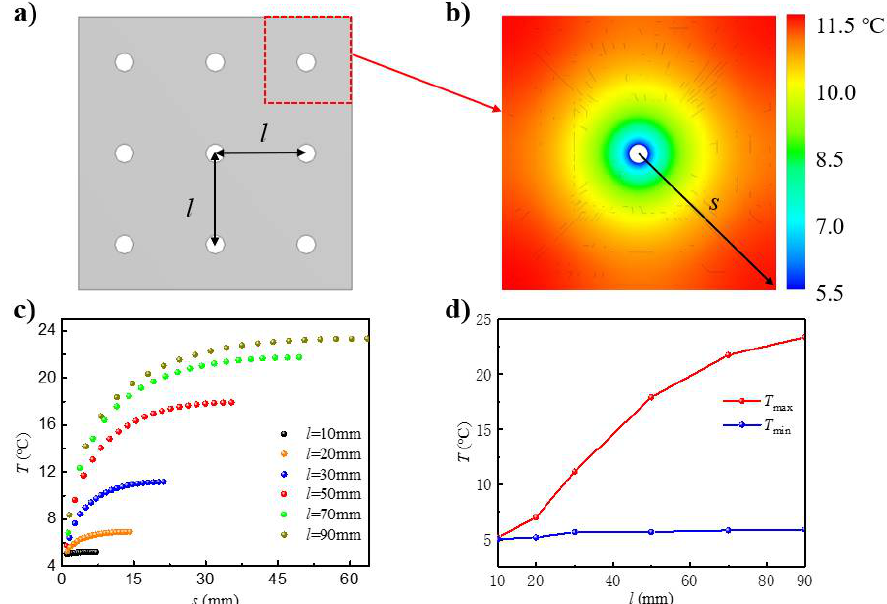
Figure 6. ( a ) Cross-sectional schematic of the active heat dissipation design with multiple flow channels in the soft substrate. ( b ) The temperature contour on the cross-section of the unit cell from FEA. ( c ) Temperature distribution along the diagonal with various channel spacings. ( d ) Maximum (red) and minimum (blue) temperatures as functions of the channel spacing.